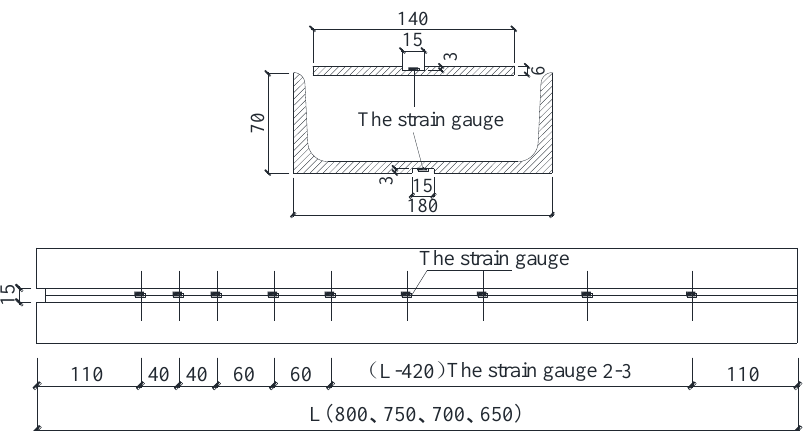
Figure 3. Strain gauge position.